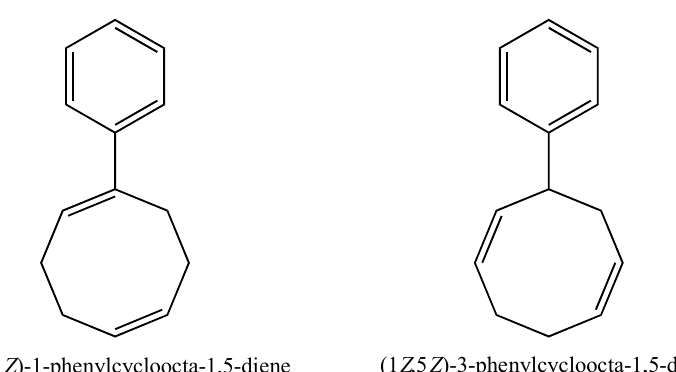
Figure 21. Possible product structures for the coupling reaction between phenylboronic acid and cis - cyclooctene.